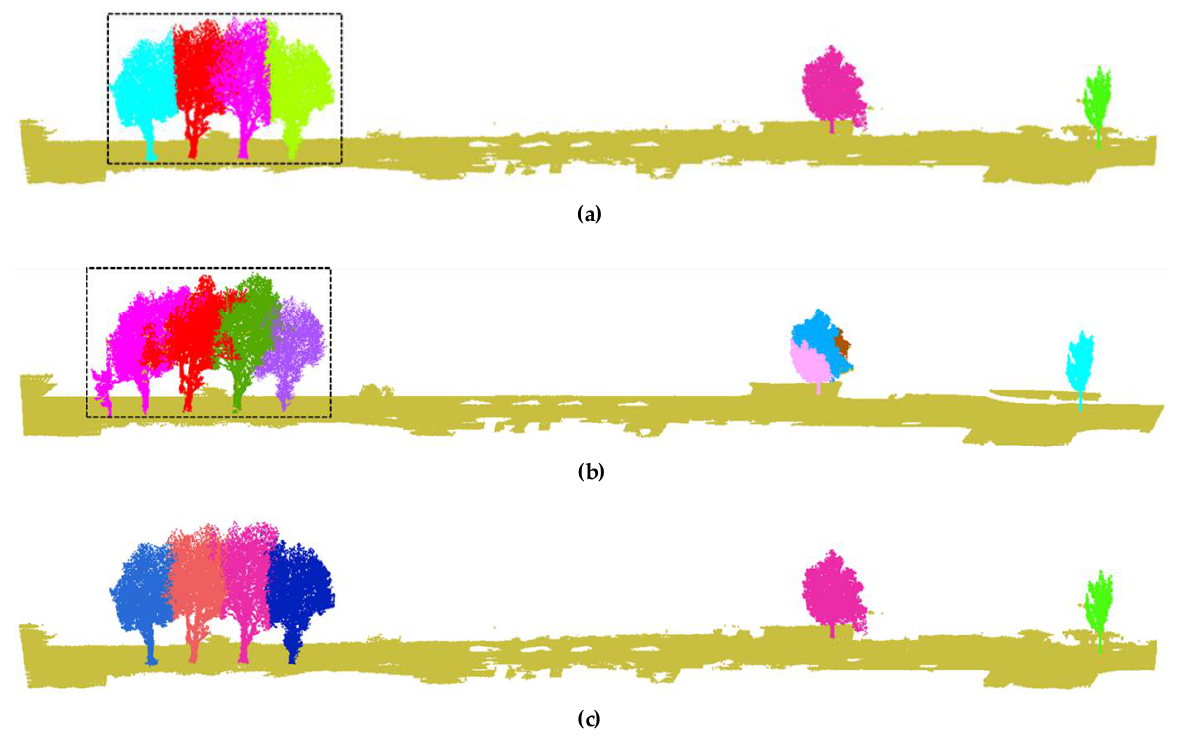
Figure 14. Comparison results in Scene 3. ( a ) Clustering based method [44]. ( b ) 3D Forest method [30]. ( c ) Our method.